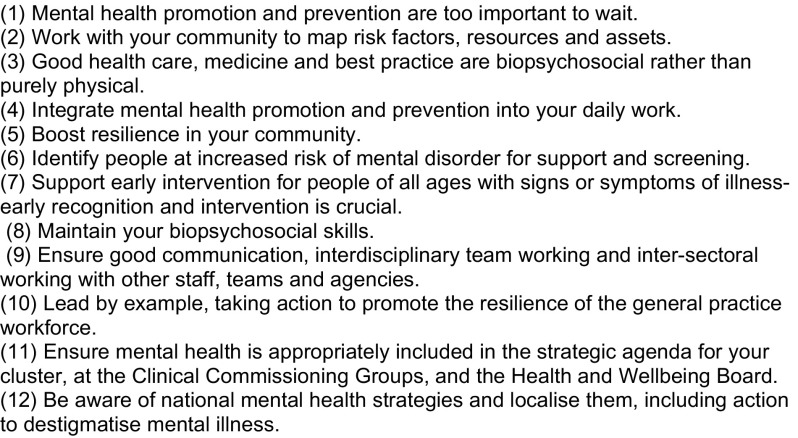
RCGP Recommendations as set out in Thomas et al. [2].